Question: Sum up the contents of this chart in one sentence.
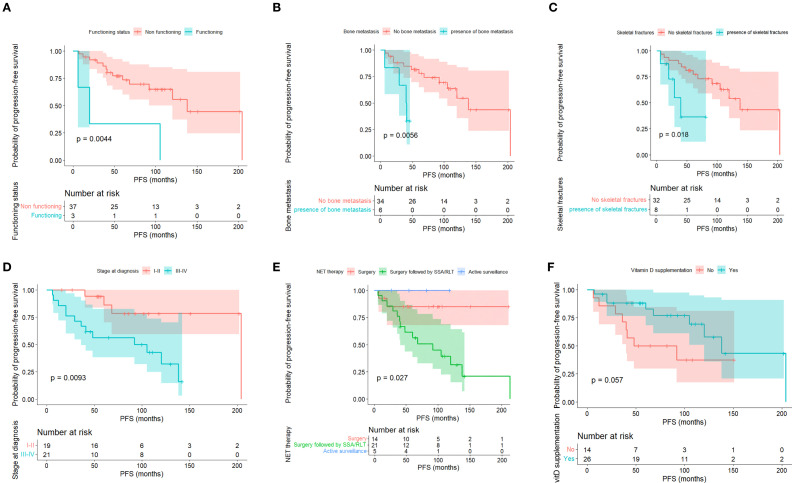
Answer: Kaplan–Meier curves for progression-free survival (PFS) according to (A) NET (neuroendocrine tumor) functioning status, (B) bone metastasis, (C) skeletal fractures, (D) NET stage at diagnosis (I-II vs III-IV), (E) NET therapy, (F) vitamin D supplementation. Statistical comparisons are reported as log-rank p-values.